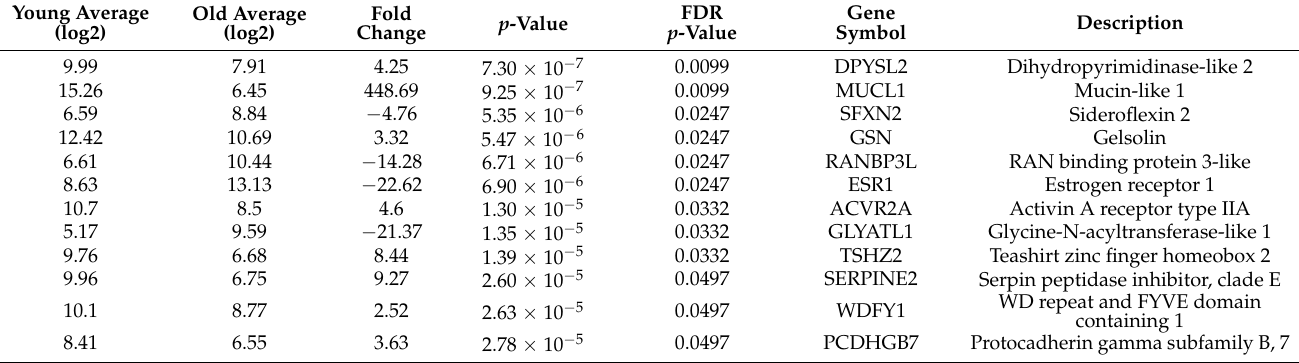
Table 2. List of the significantly differentially expressed genes by young-age breast cancer